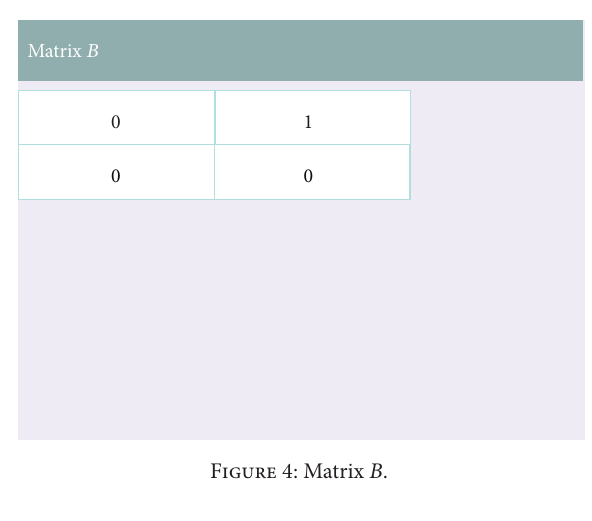
Figure 4: Matrix 𝐵